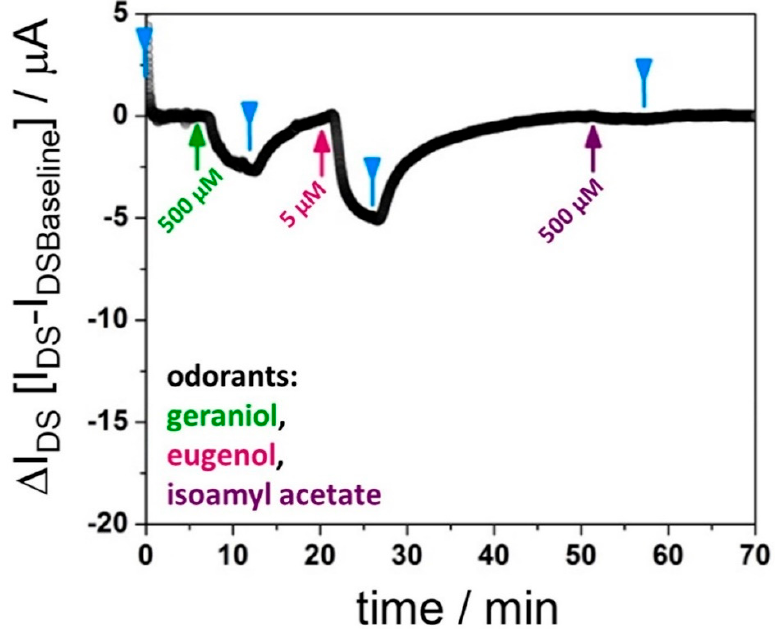
Figure 3. Kinetic runs with one rGO-FET device, functionalized with BmorPBP1; however, subse- quently exposed in the flow cell to different analyte (odorant) solutions: geraniol, eugenol, isoamyl acetate, as indicated; binding (k obs ) and dissociation (k off ) rate constants are obtained from fits ac- cording to Equations (2) and (3), respectively, for geraniol and eugenol, and are used to approximate the dissociation constant for these ligands, as summarized in Table 1. Isoamyl acetate does not give a significant response of Δ I DS .